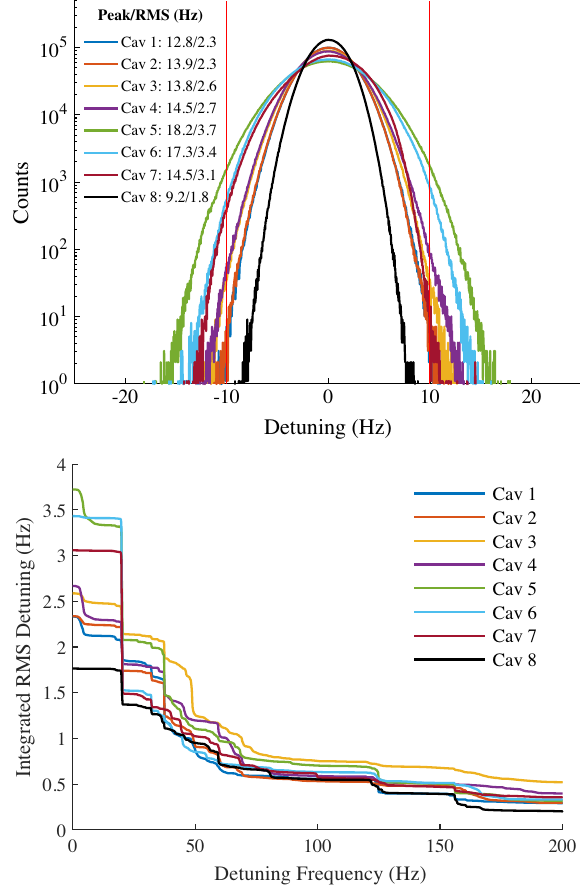
FIG. 21. Top: histogram of the detuning of the eight cavities over a 4.5 hour period. The goal is not to exceed (cid:2) 10 Hz (red lines) at six sigma. Bottom: integrated rms detuning for the eight cavities from the frequency computed to 500 Hz.